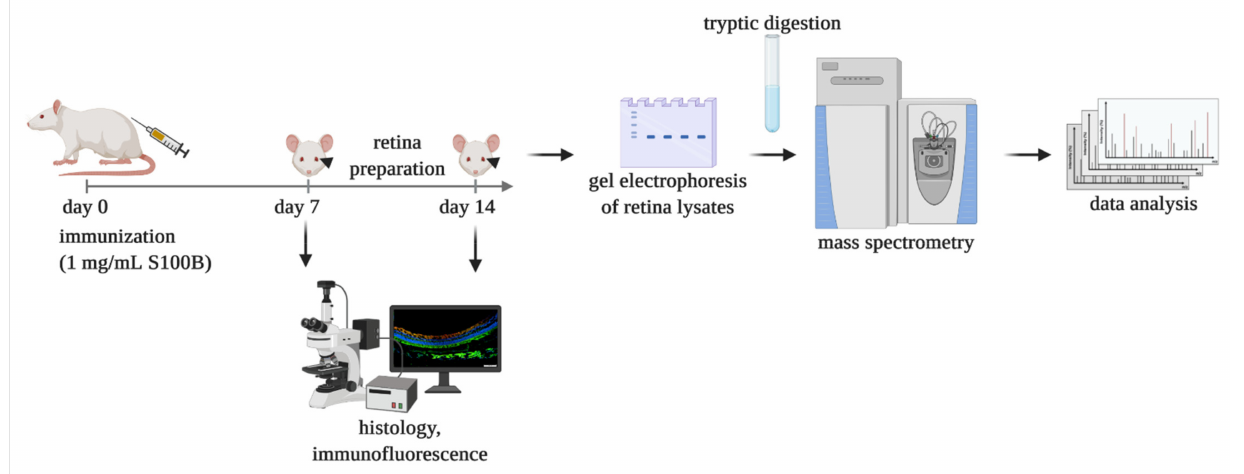
Figure 1. Study overview. Schematic study setup created with biorender.com (accessed on 15 October